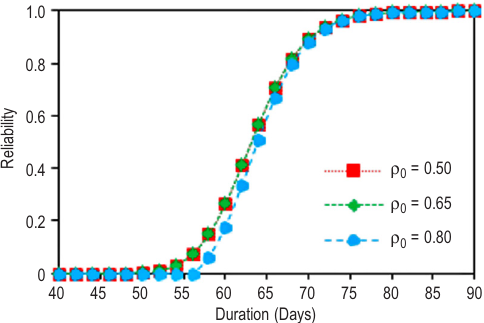
Fig. 6. Reliability of project completion time for different ρ 0